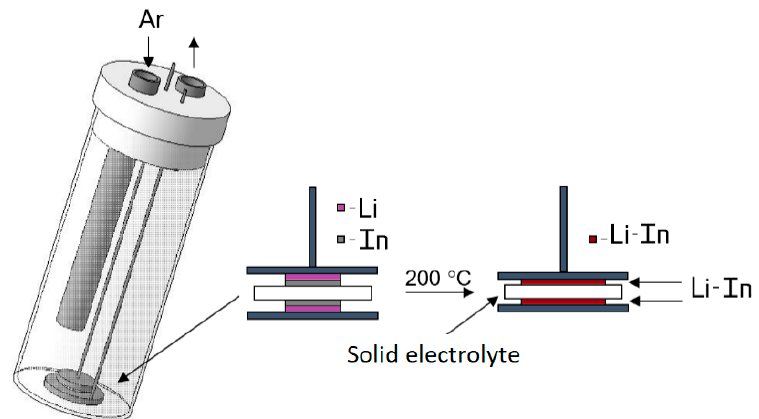
Figure 1. The scheme for demonstrating the in situ method.